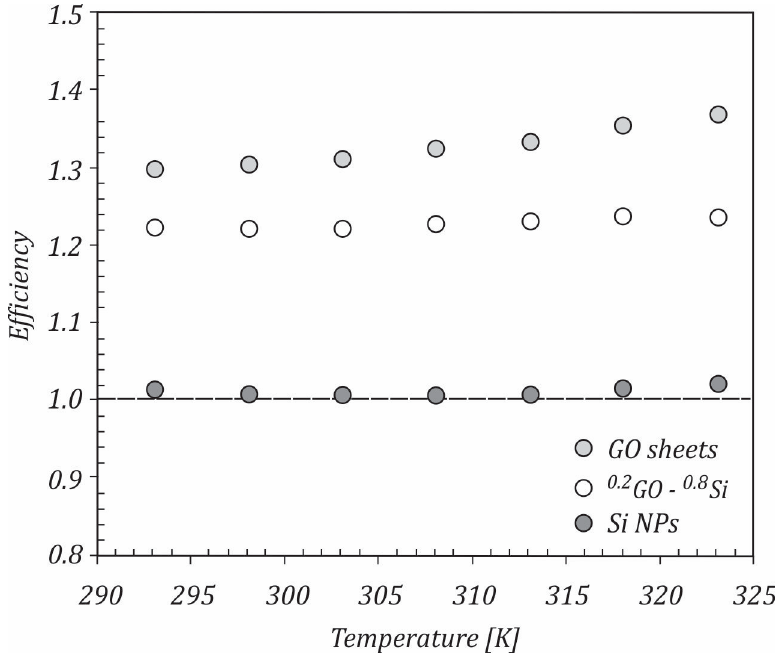
Figure 13. Efficiency of the studied nanofluid.